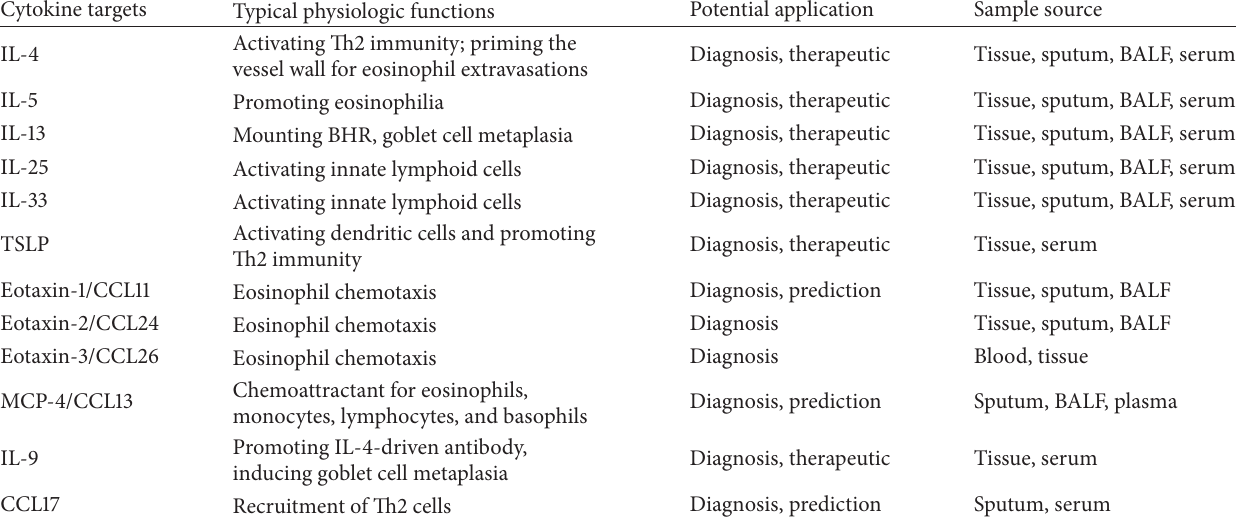
Table 1: Cytokines as biomarkers in asthma explored in these